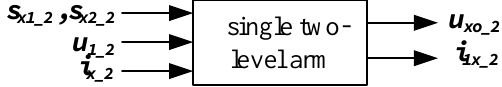
Figure 2. Inputs and outputs of a single two-level